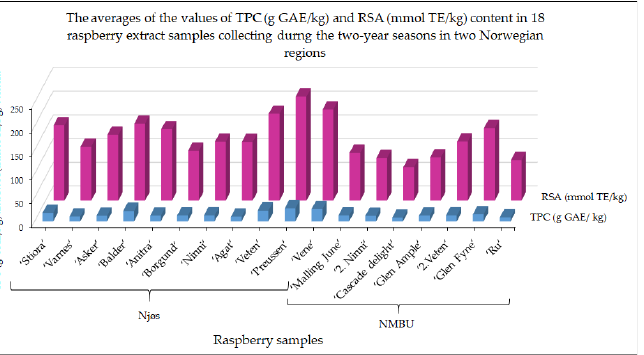
Figure A1. The averages of the values of TPC and RSA obtained for 18 raspberry varieties during the two-year collection.